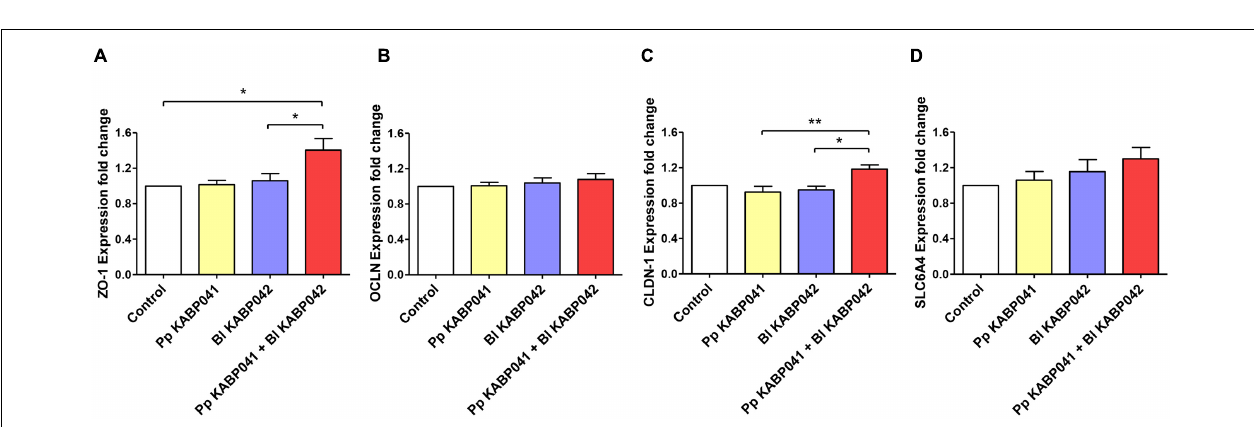
FIGURE 1 | (A) Adhesion capacity to Caco-2 cells, (B) number of adhesion proteins and (C) number of total adhesion domains of L. paracasei ATCC 334 (Lpar 334), B. longum ATCC 15707 (Bl 15707), P. pentosaceus KABP041 (Pp KABP041) and B. longum KABP042 (Bl KABP042). Statistical differences were assessed by one-way ANOVA followed by Bonferroni’s Multiple Comparison test. * p < 0.05; ** p < 0.001.